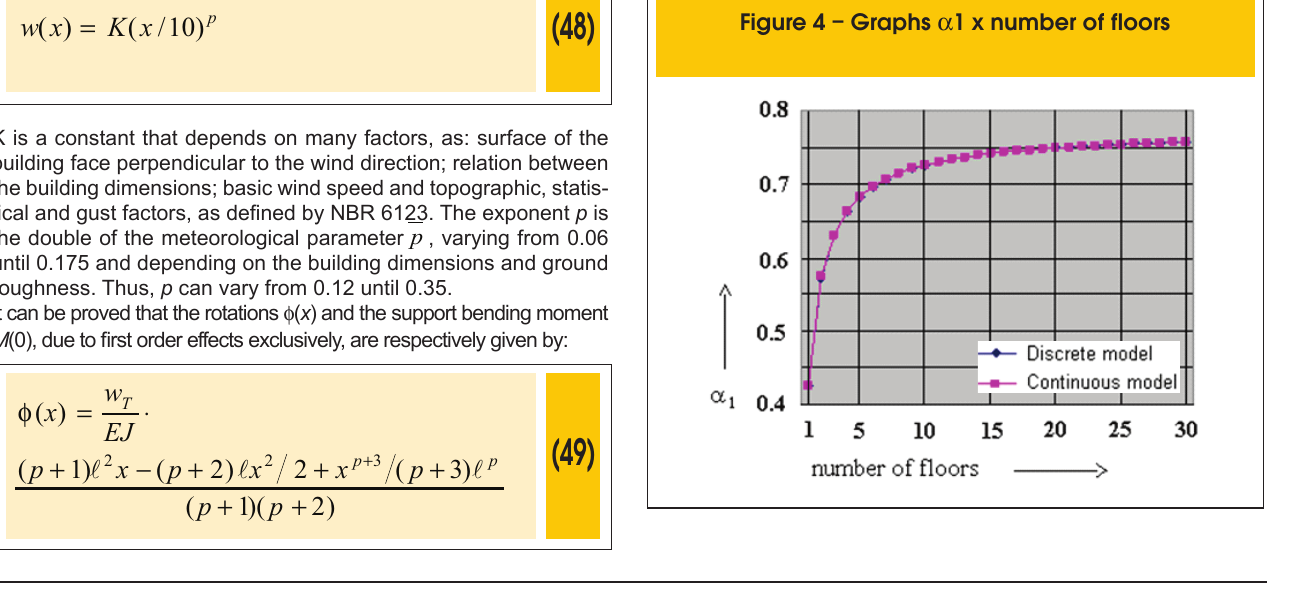
Figure 4 – Graphs a 1 x number of